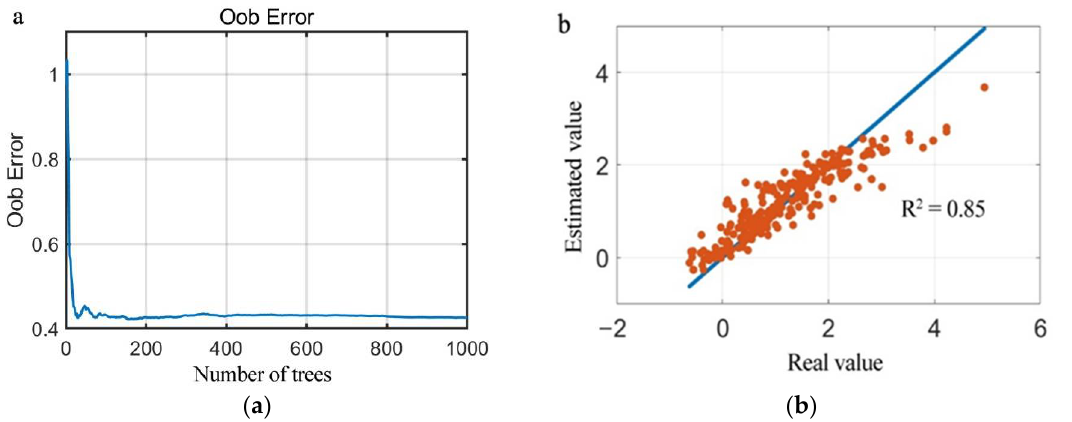
Figure 4. Number of trees for random forest model and the results. ( a ) number of trees, ( b ) the results of random forest model.